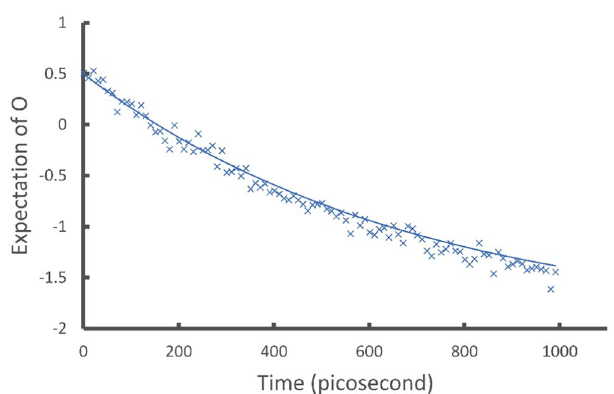
Figure 3. Showing the expectation values O . The smooth line is obtained by classical numerical calculations of the output vectors. This agrees exactly with analytic results and is used as a benchmark. The crosses are obtained by the IBM Qiskit simulator. The quantum circuits include 3 qubits and on average 184 elementary gates (see the SI for the circuits). Due to the large number of gates required the quantum device is not used for these results.